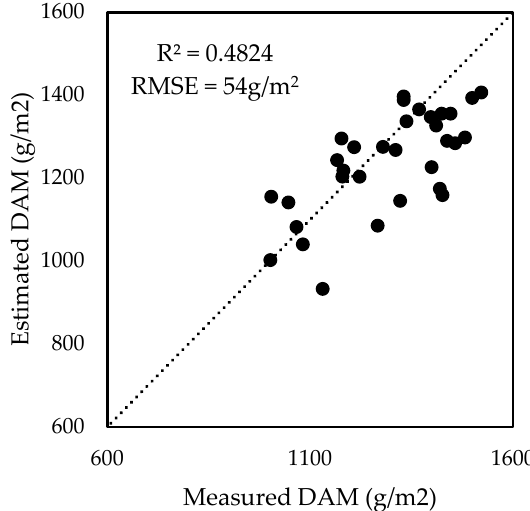
Figure 8. Relationship between the measured and estimated dry above-ground biomass (DAM) using SAFY model for S2.